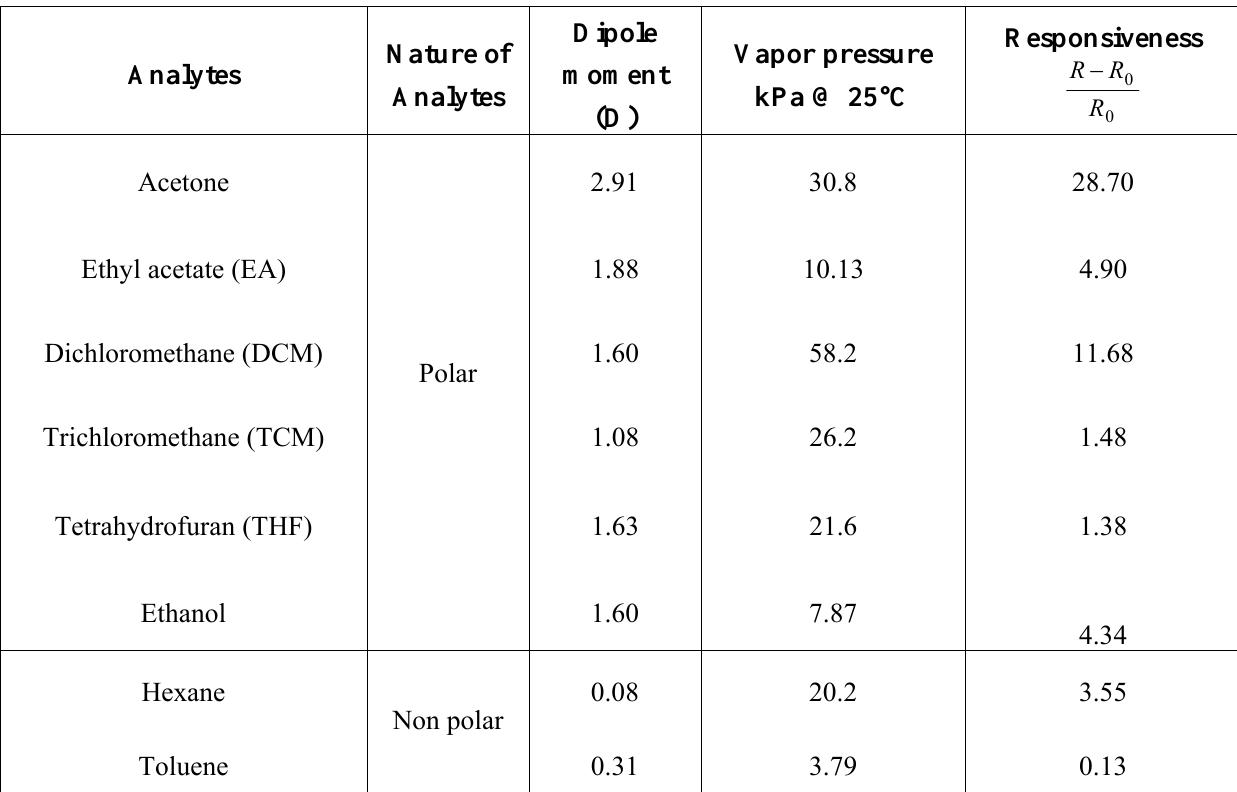
Table 1. Performance of sa MWCNTs/Nylon-6 nanofiber composite towards the various types of